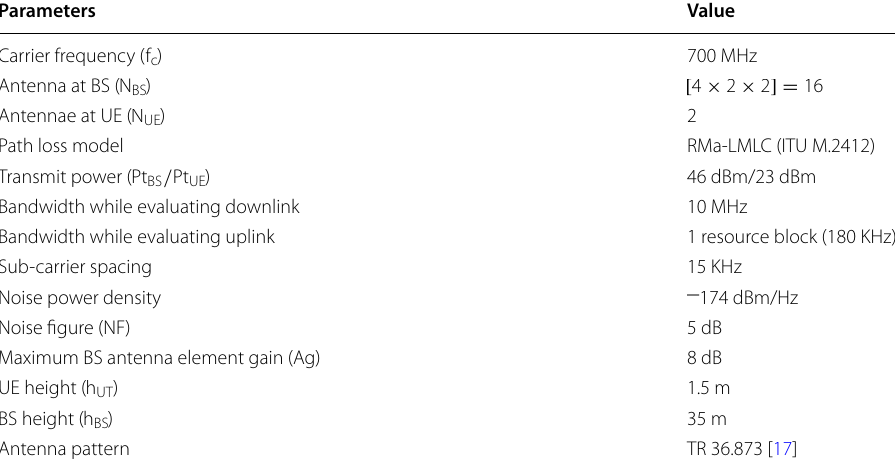
Table 1 Link budget simulation